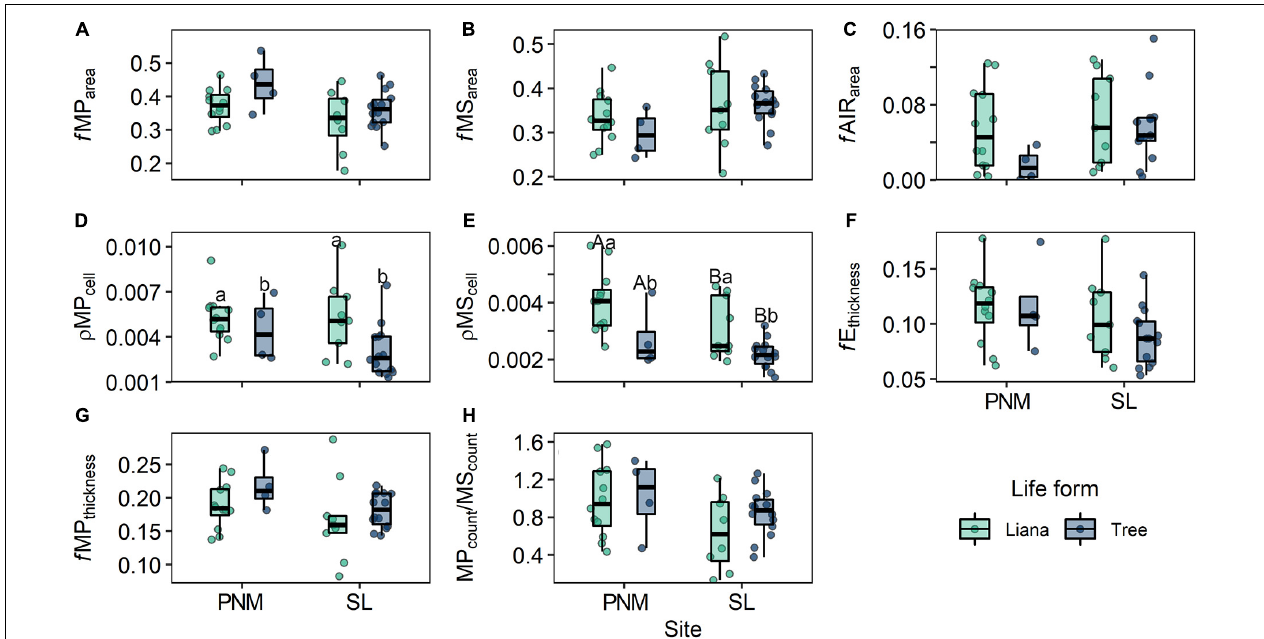
FIGURE 1 | Comparisons of the leaf anatomical traits of lianas and trees at Parque Natural Metropolitano (PNM) and Parque Nacional San Lorenzo (SL). Different capital letters represent a statistical difference between forest types, while different lowercase letters represent a statistical difference between life forms. Each point represents the mean value per species. Each fractional anatomical trait ( f MP area , f MS area , f AIR area , f E thickness , f MP thickness , and MP count /MS count ) does not have units, however, area and thickness are measured in µ m. While the units for, ρ MP cell and ρ MS cell are the number of cells per µ m. ANOVA results are described in Table 4 . See Table 3 for abbreviations of traits. TABLE 6 | Comparison of the well-established leaf traits between lianas and trees summarized by forest type: seasonally dry forest, Parque Natural Metropolitano, and wet forest, Parque Nacional San Lorenzo. Traits Parque Natural Metropolitano Parque Nacional San Lorenzo ANOVA Lianas Trees Lianas Trees Life form Site